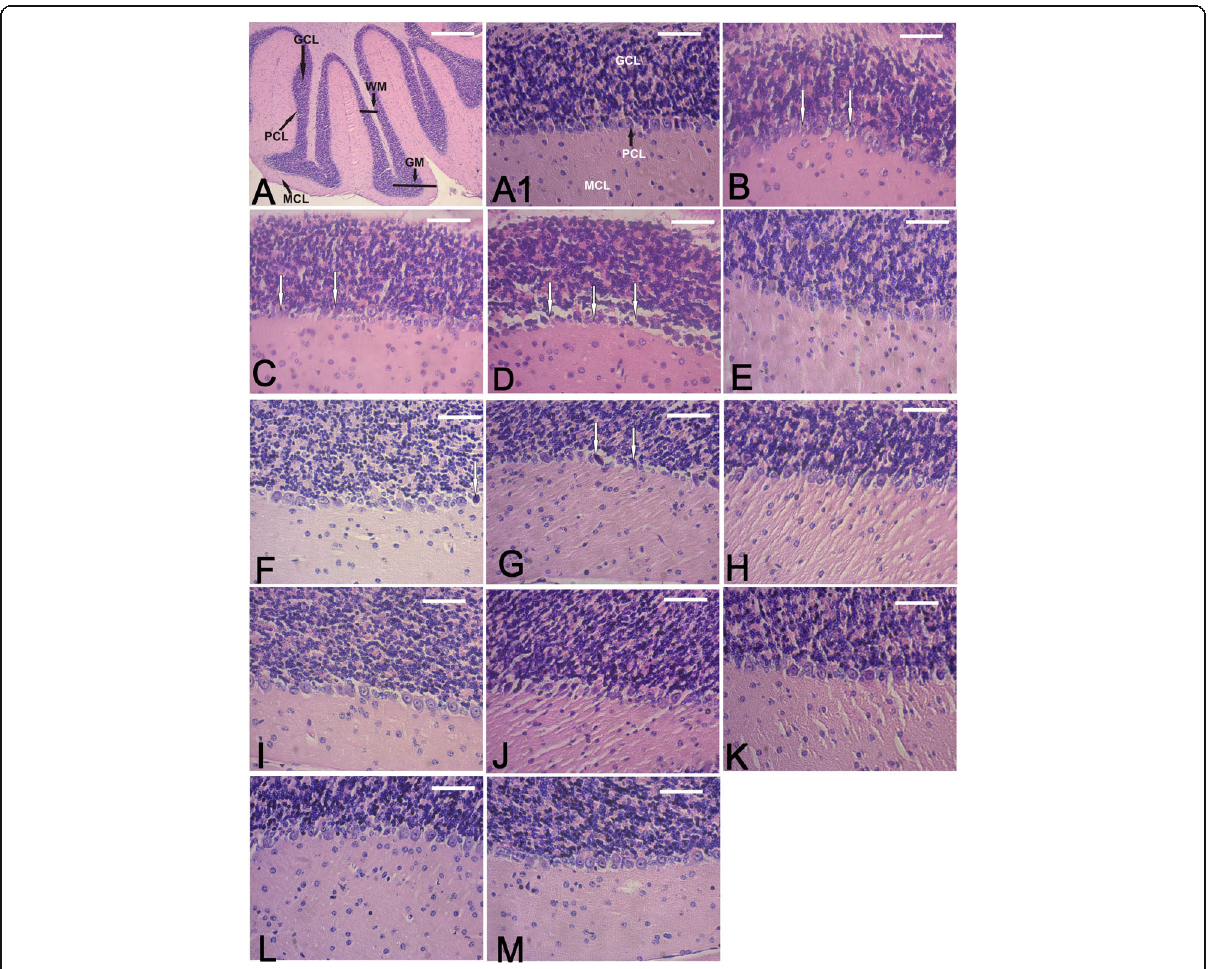
Fig. 6 Photomicrographs of the cerebellar region showing the gray (GM) and white matter (WM), granular cell layer (GCl), Purkinje cell layer (PCL), and the molecular cell layer (MCl) of control are shown ( A , A1 ). In the acrylamide-administrated groups, degeneration of the Purkinje cell was shown at 60 days (arrows, D ) compared to 30 and 45 days (arrows; B , C ) and the control ( A1 ). In the chips feeding groups, Purkinje cell degeneration was noted at 60 (arrows, G ) than at 30 ( E ) and 45 (arrows, F ) days of feeding. The BV- ( H ) and BPF-treated groups at 60 days of treatment ( I ) showed Purkinje cells similar to the control. The acrylamide-administrated groups treated with either BV ( J ) or BPF ( K ) showed improvement compared to degeneration which has been detected in the acrylamide group. The chips feeding groups treated with either BV ( L ) or BPF ( M ) showed improvement in Purkinje cell integrity compared to chips-induced Purkinje cell degeneration. H&E stain; scale bar, A 50 μ m; A1 – M 10 μ